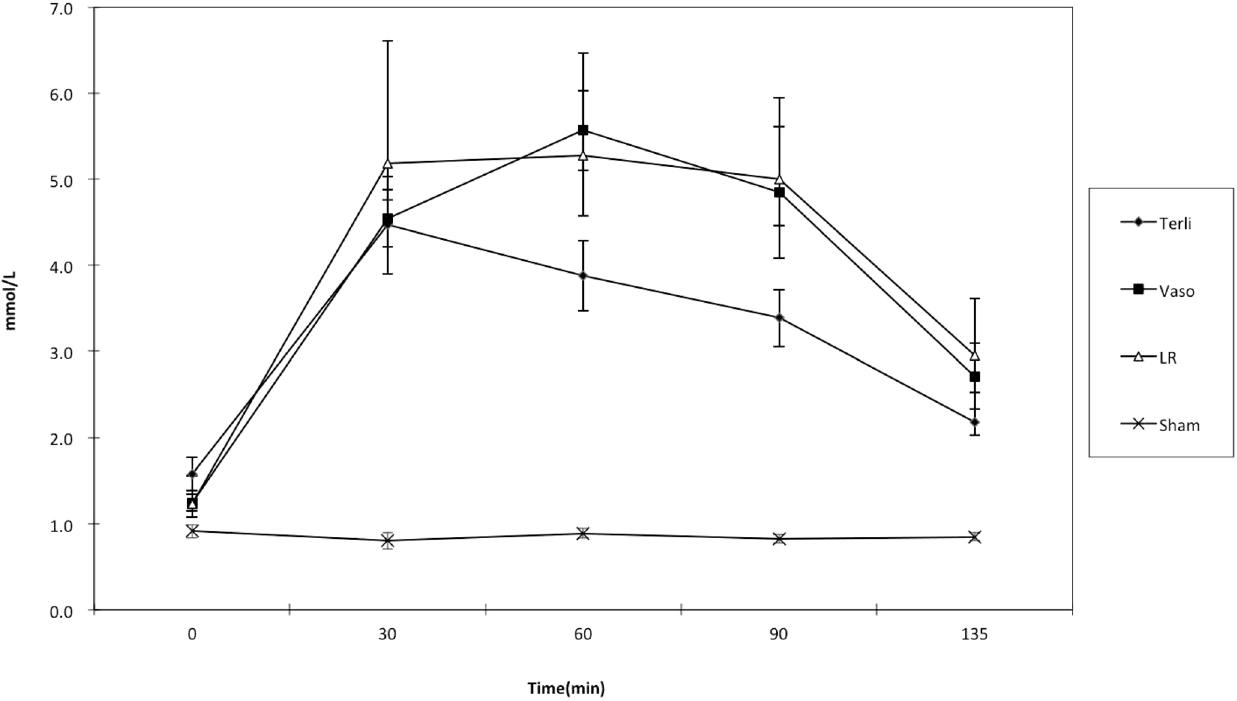
Figure 2. Comparison of serum lactate levels between different resuscitation strategies groups from 0 to 135 min. Data are shown as mean values and standard deviations. There were no significant differences in baseline levels. The Terli group had significantly lower serum lactate level than Vaso or LR group at 60 and 90 min. At the end of resuscitation, there was no statistical difference among three different resuscitation strategies groups.